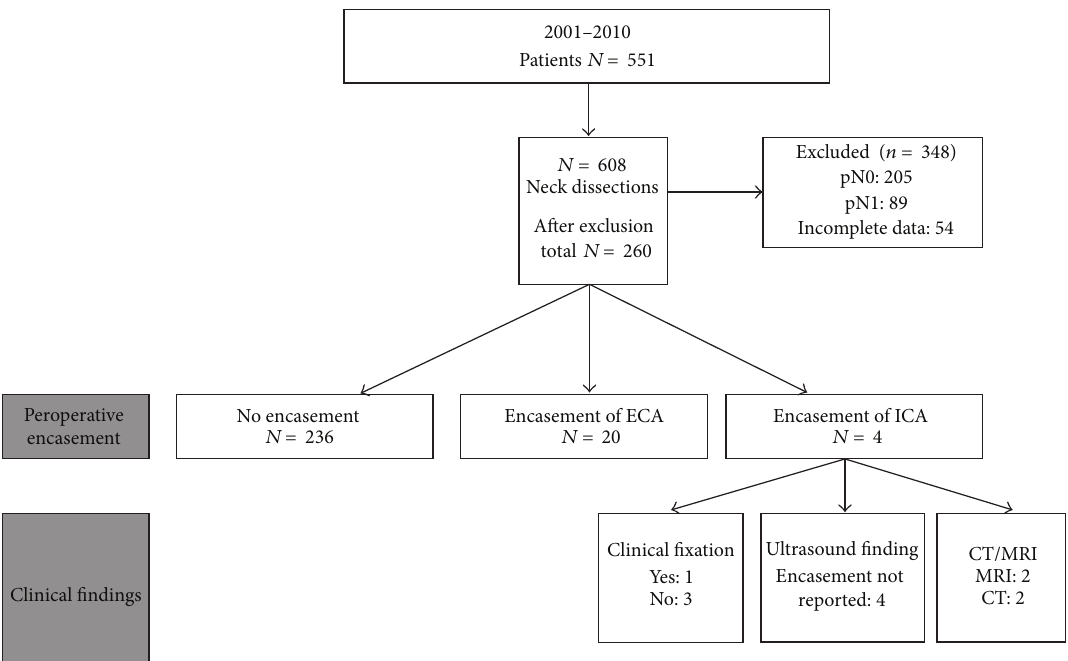
Figure 1: Neck dissections performed between 2001 and 2010. ECA: external carotid artery. ICA: internal carotid artery. This figure shows 551 patients in which 608 neck dissections were performed. In total 260 cases were studied after exclusion. In 236 cases no encasement was found during operation. In 20 cases (7.7%) encasement of the external carotid artery was seen. In four cases encasement of the internal carotid artery was present (4/260 = 1.5%). Two cases had MRI and 2 had CT